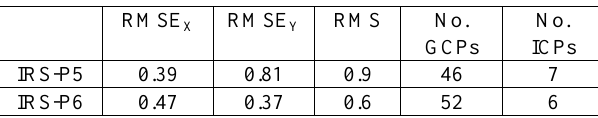
Table 1. Geometric correction